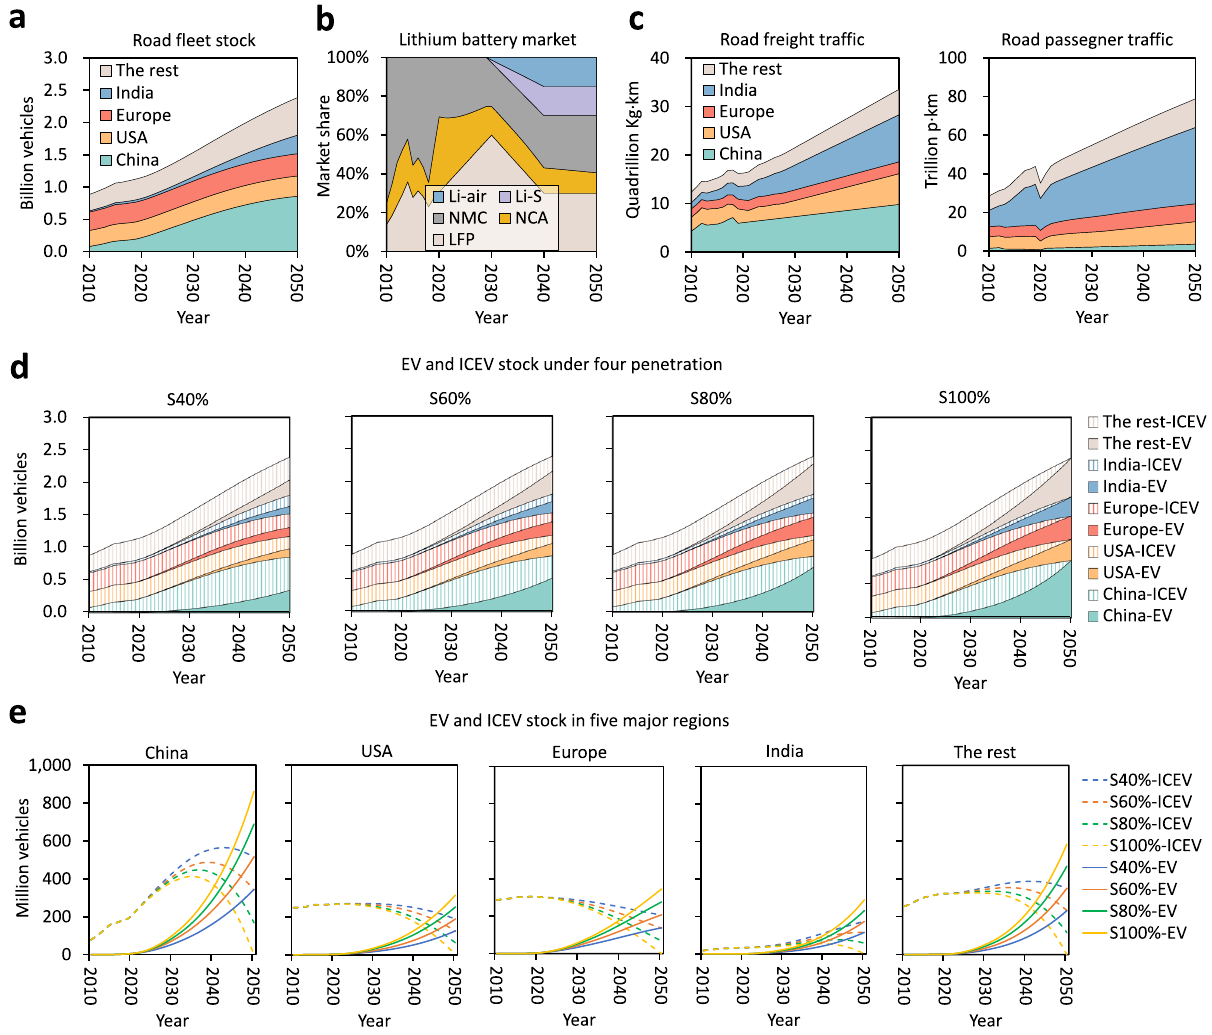
Fig. 1 | Future markets of road fl eet, lithium-ion batteries, and freight and passenger traf fi c. a Road fl eet stock of China, the USA, Europe, India, and the rest of theregions. b Projectionofthefuturelithium-ionbatterymarket. c Road freight (expressed in Kg·km, or one kilogram transported over one kilometer) and